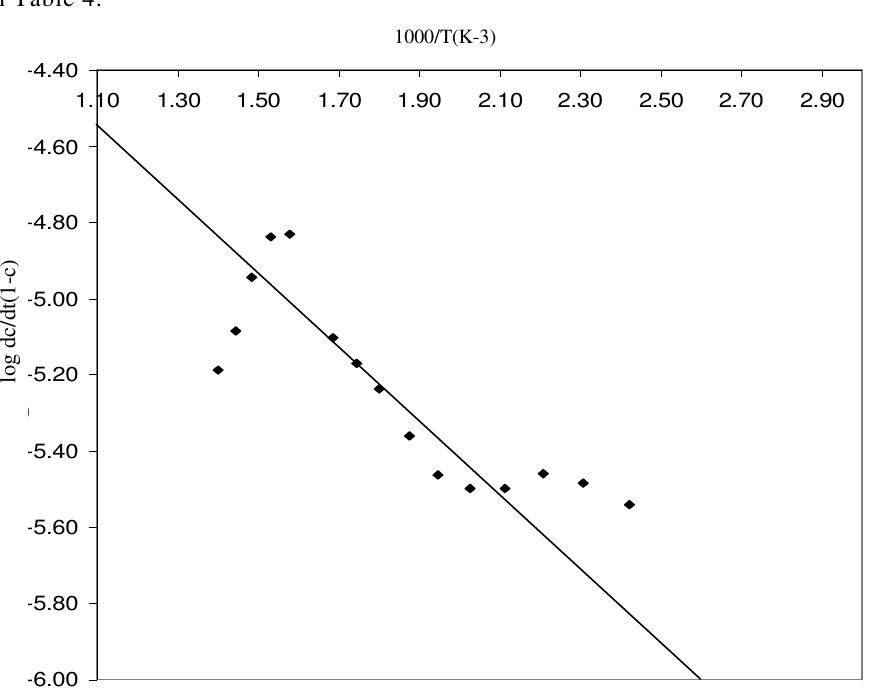
Figure 5 . Sharp Wentworth plot of p -CDF terpolymer